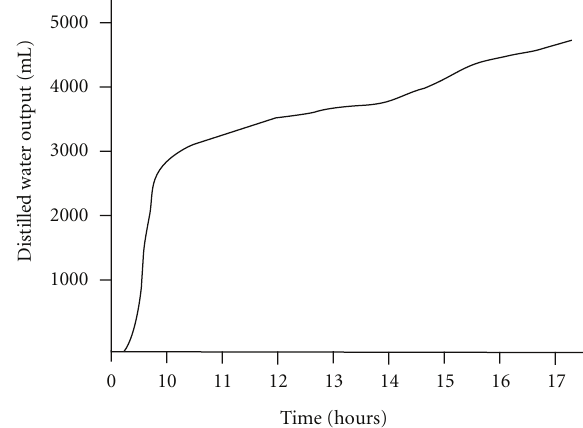
Figure 6: Distilled water output of this solar still as function of time.